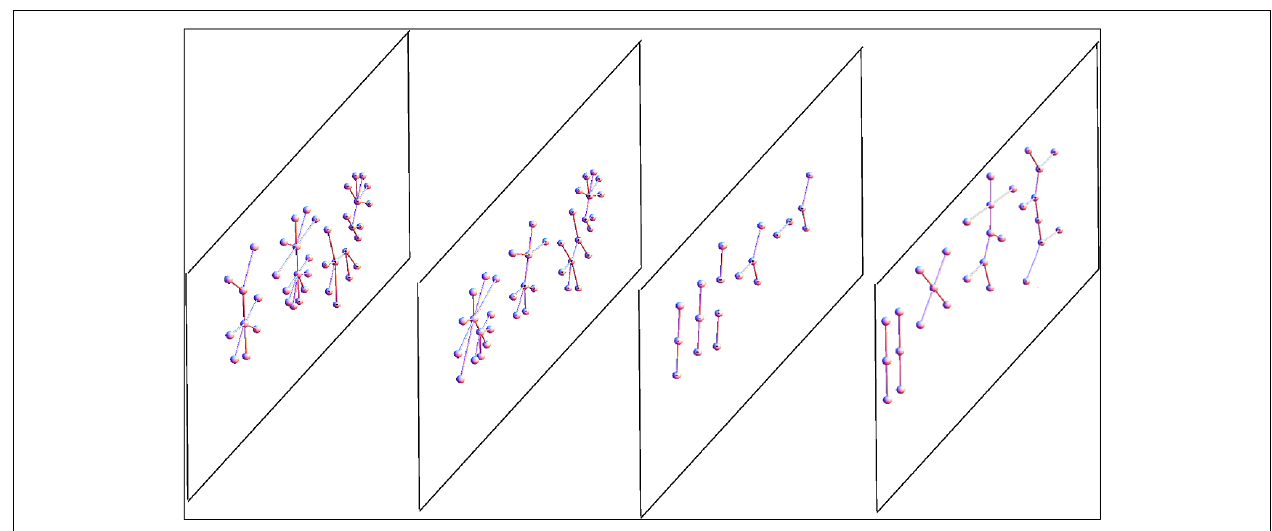
proteins (produced by the genes) can interact, bind, or be co-expressed, and in the third layer the enzymes encoded by the proteins are embedded in a metabolic network.The typical network observables (e.g., connectivity) that in a single network are scalar values for each node, in a multiplex become a vector (one value for each layer), thus the relationship between nodes based on these vectors can be more complex than in a single